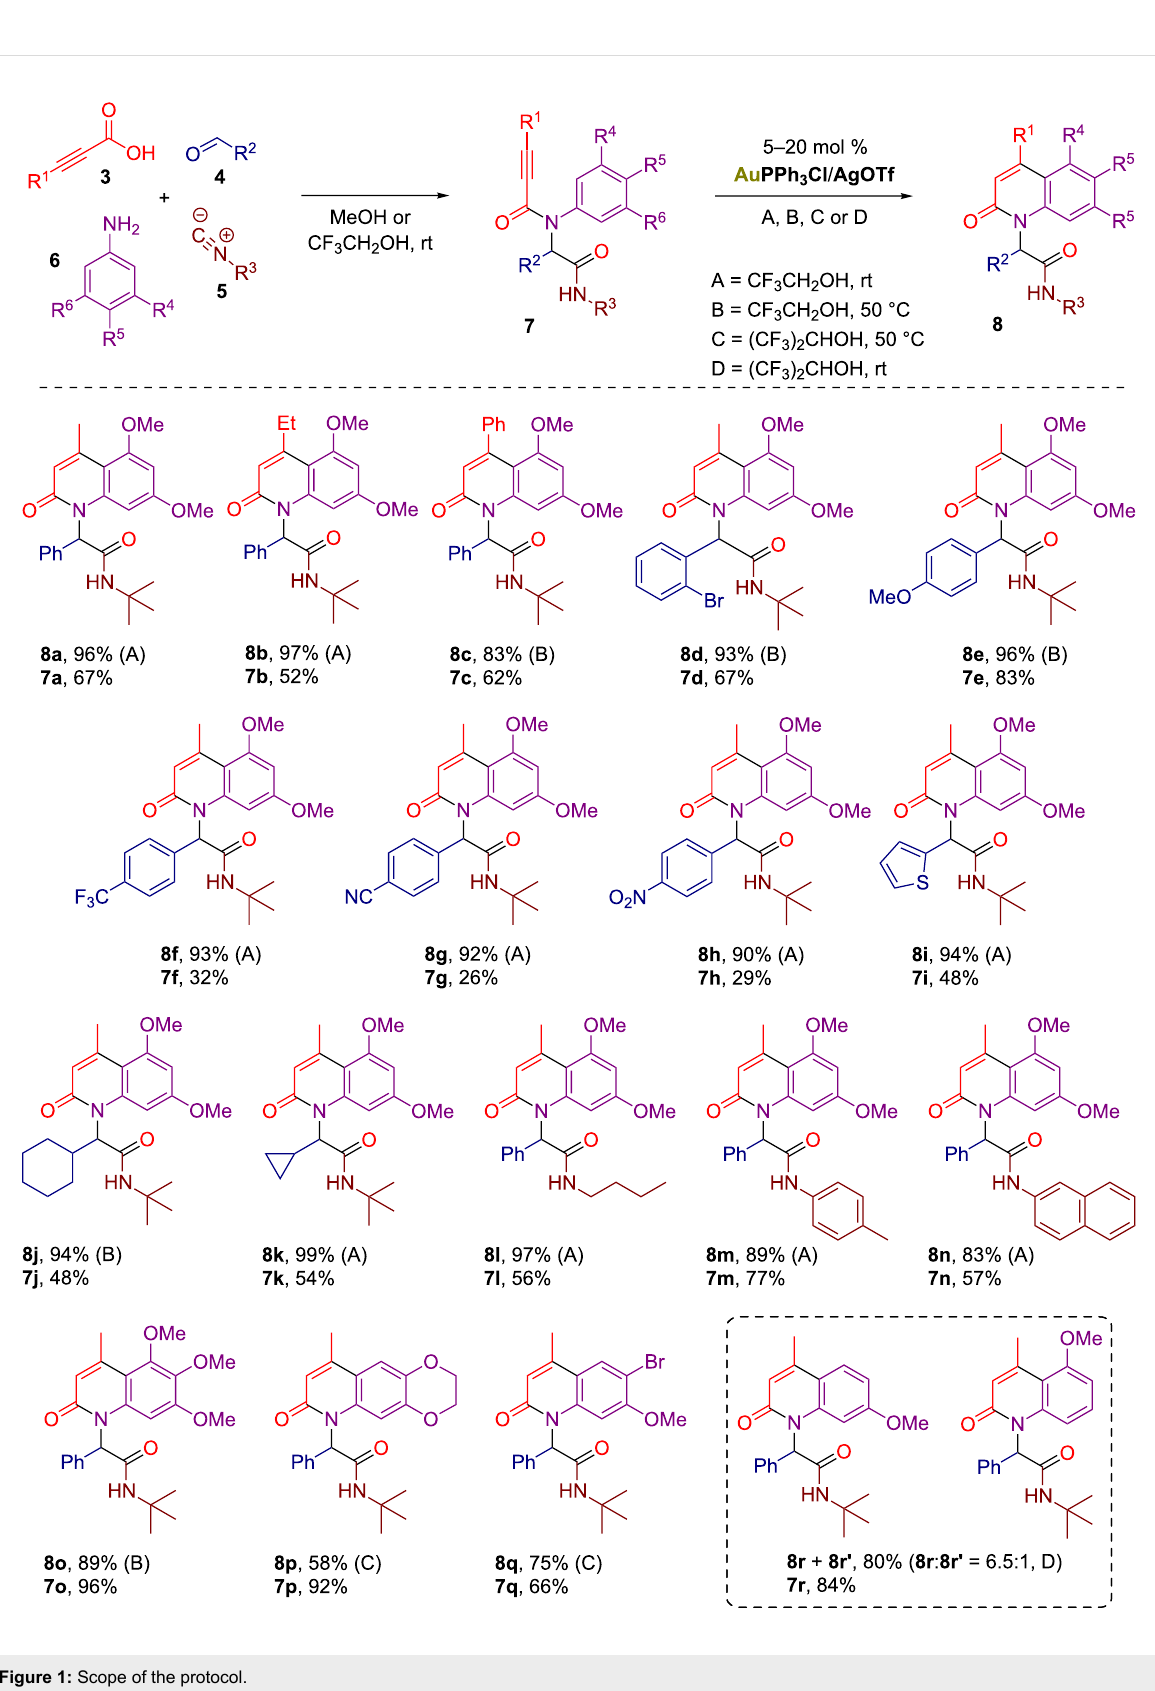
Figure 1: Scope of the